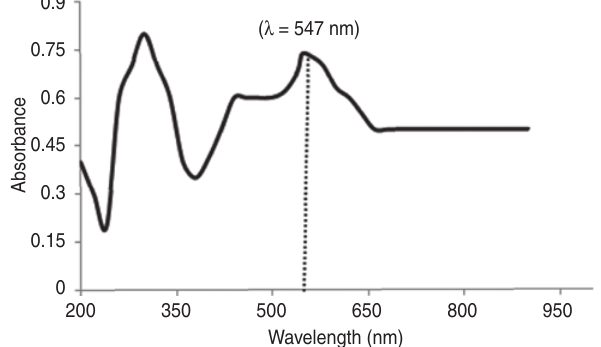
Figure 2: UV-Vis spectra of gold nanoparticles.